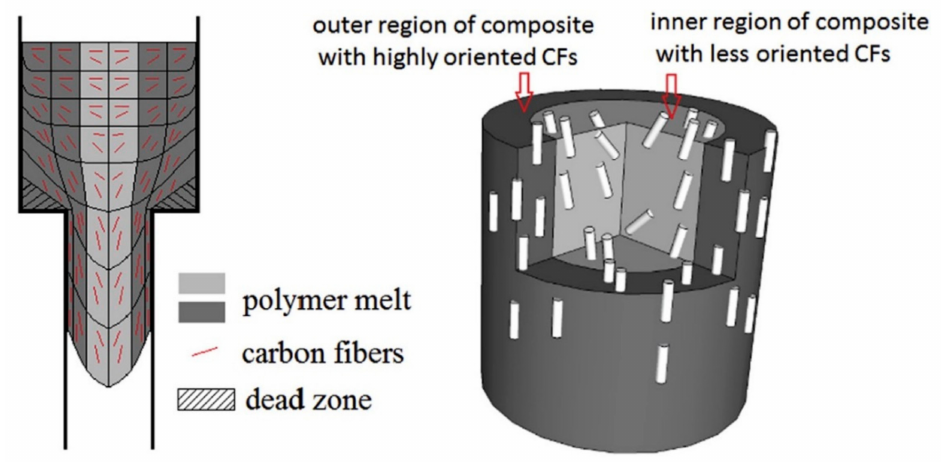
Figure 14. Schematic illustration of orientation and morphology of carbon fiber in different regions of CF/PMMS composites. Reprinted with permission from [106]. Copyright 2016 Elsevier Ltd.